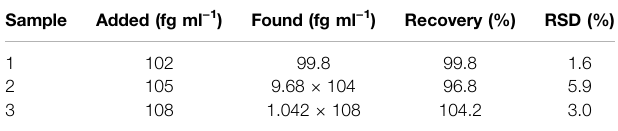
TABLE 3 | The recovery determination in real wheat fl our samples